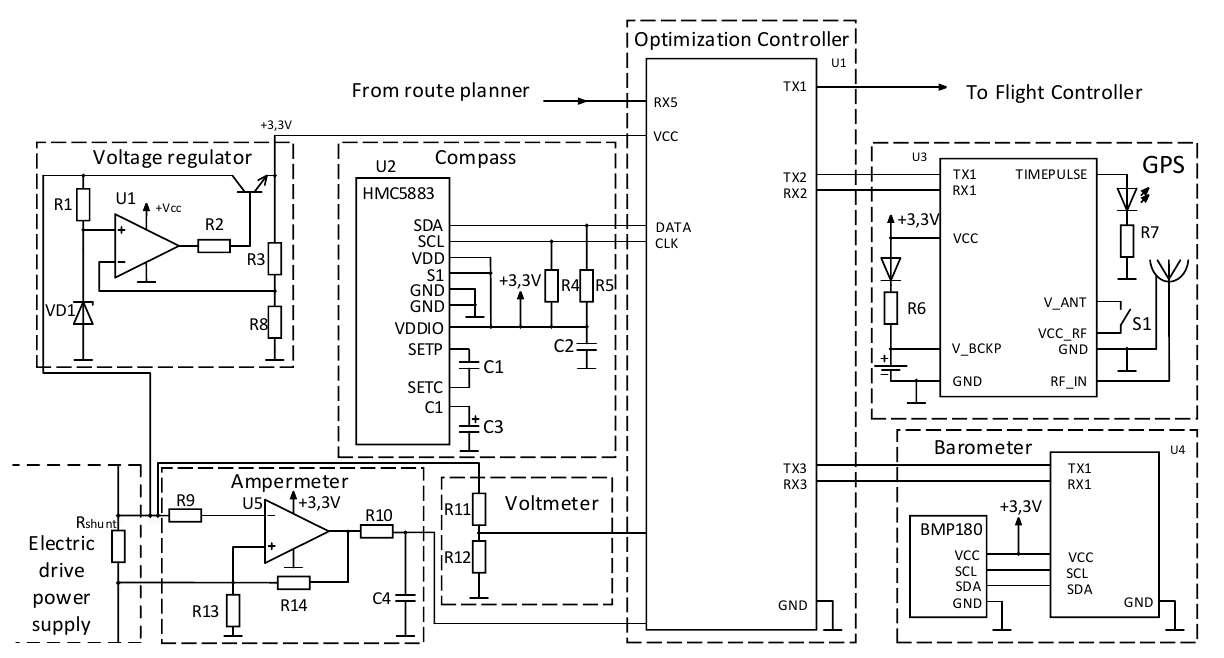
Fig. 1. Improved control structure of quadcopter UAV as example with optimization controller.